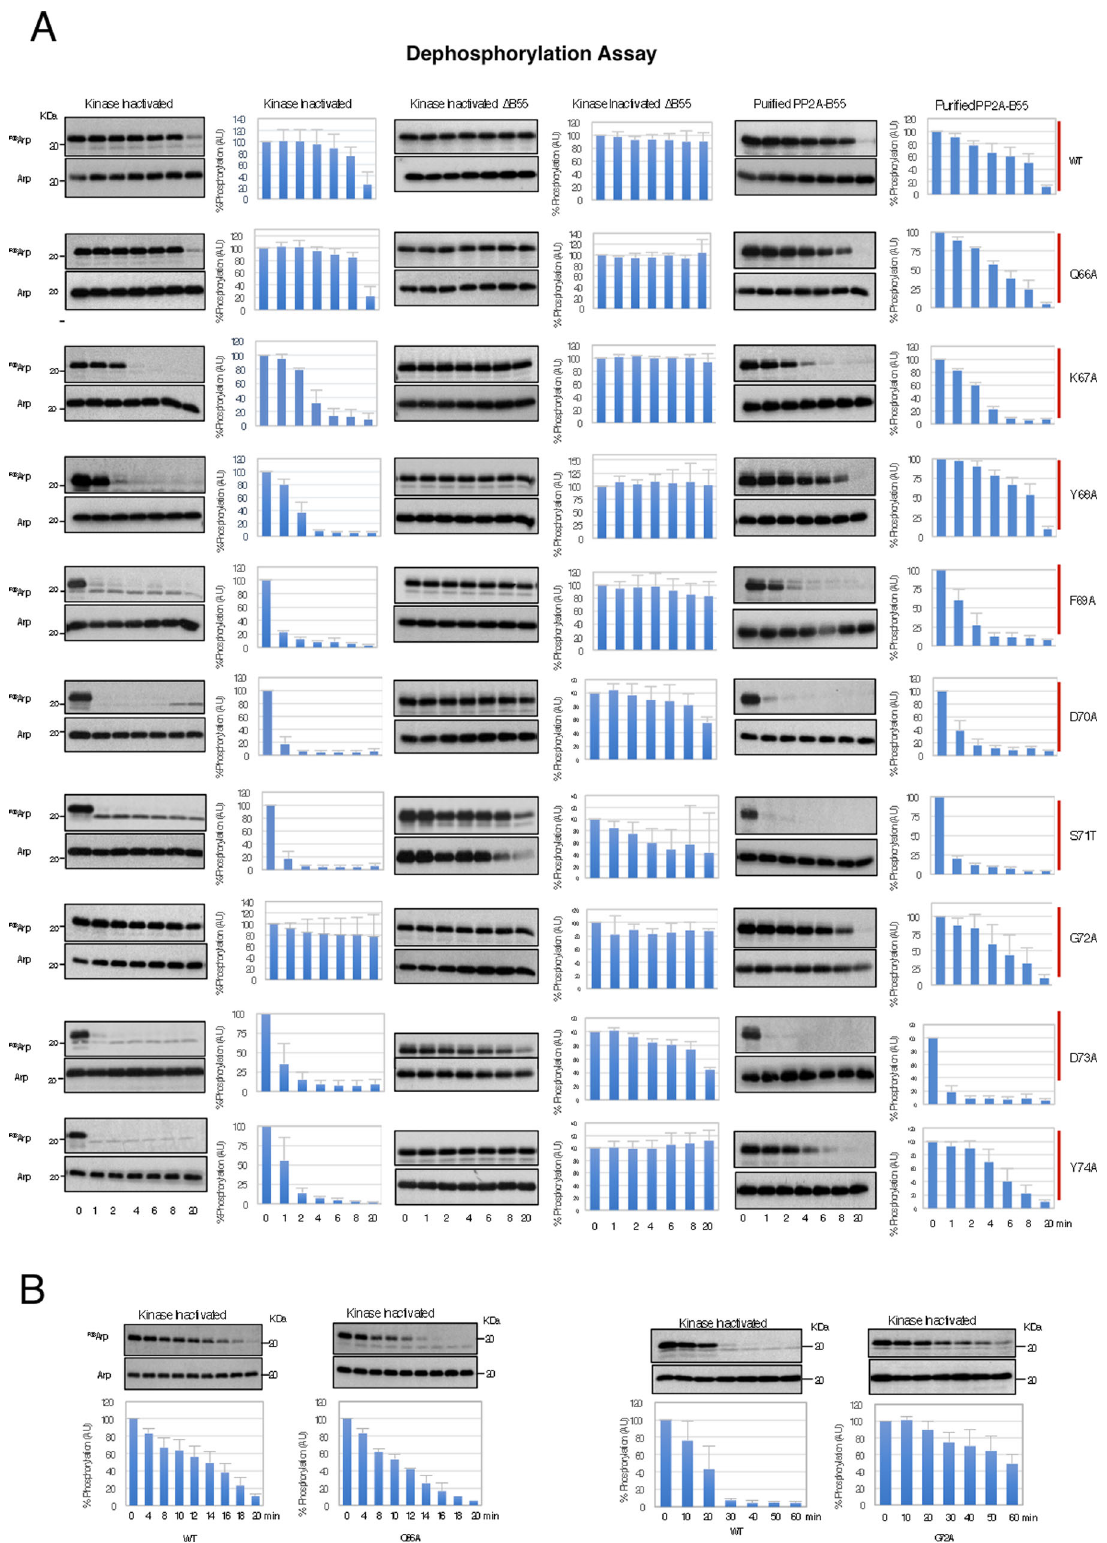
Fig. 2 Aromatic and acidic residues fl anking S67/S71 Gwl site are essential for slow Arpp19 dephosphorylation rate. A S67/S71 dephosphorylation of wild-type Arpp19 or of the indicated DSG Arpp19 mutants was measured in kinase-inactivated extracts depleted or not of B55, as well as upon the addition of a puri fi ed PP2A-B55 phosphatase by autoradiography ( P33 Arp). The amount of Arpp19 in each sample was assessed by western blot (Arp). The percentage of phosphorylation remaining with respect to the starting point calculated as in Fig. 1B and represented in bar graph as the mean value ± SD; n = 3 biological independent samples. B Dephosphorylation of the wild type and the indicated mutants of Arpp19 were performed in kinase-inactivated extracts and quanti fi ed in a bar graph as the mean value ± SD; n = 3 biological independent samples.